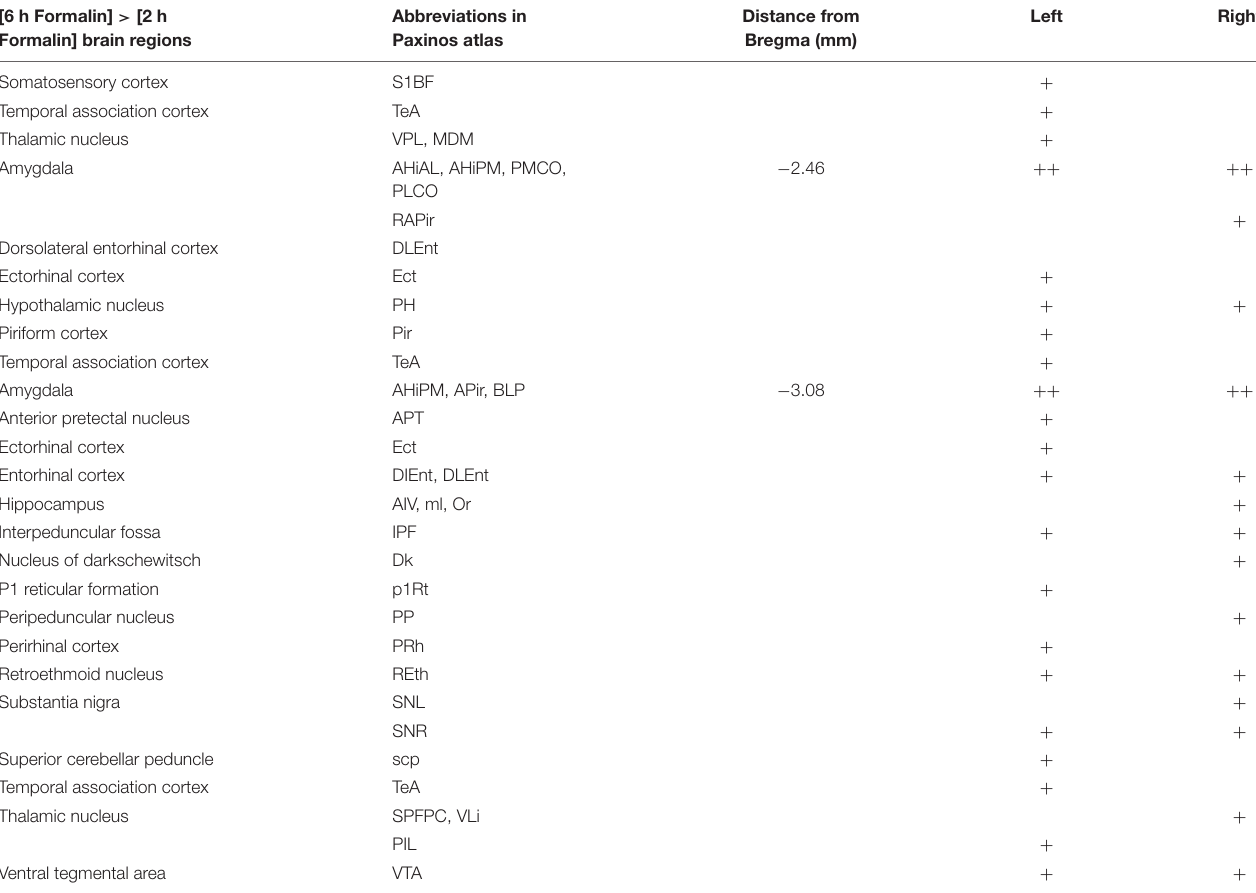
[hM4D] mice ( Figure 5D , P < 0.005, Wilcoxon signed-rank test; from 6.1 ± 0.4 to 4.2 ± 0.5 action potentials/500 ms; n = 11)